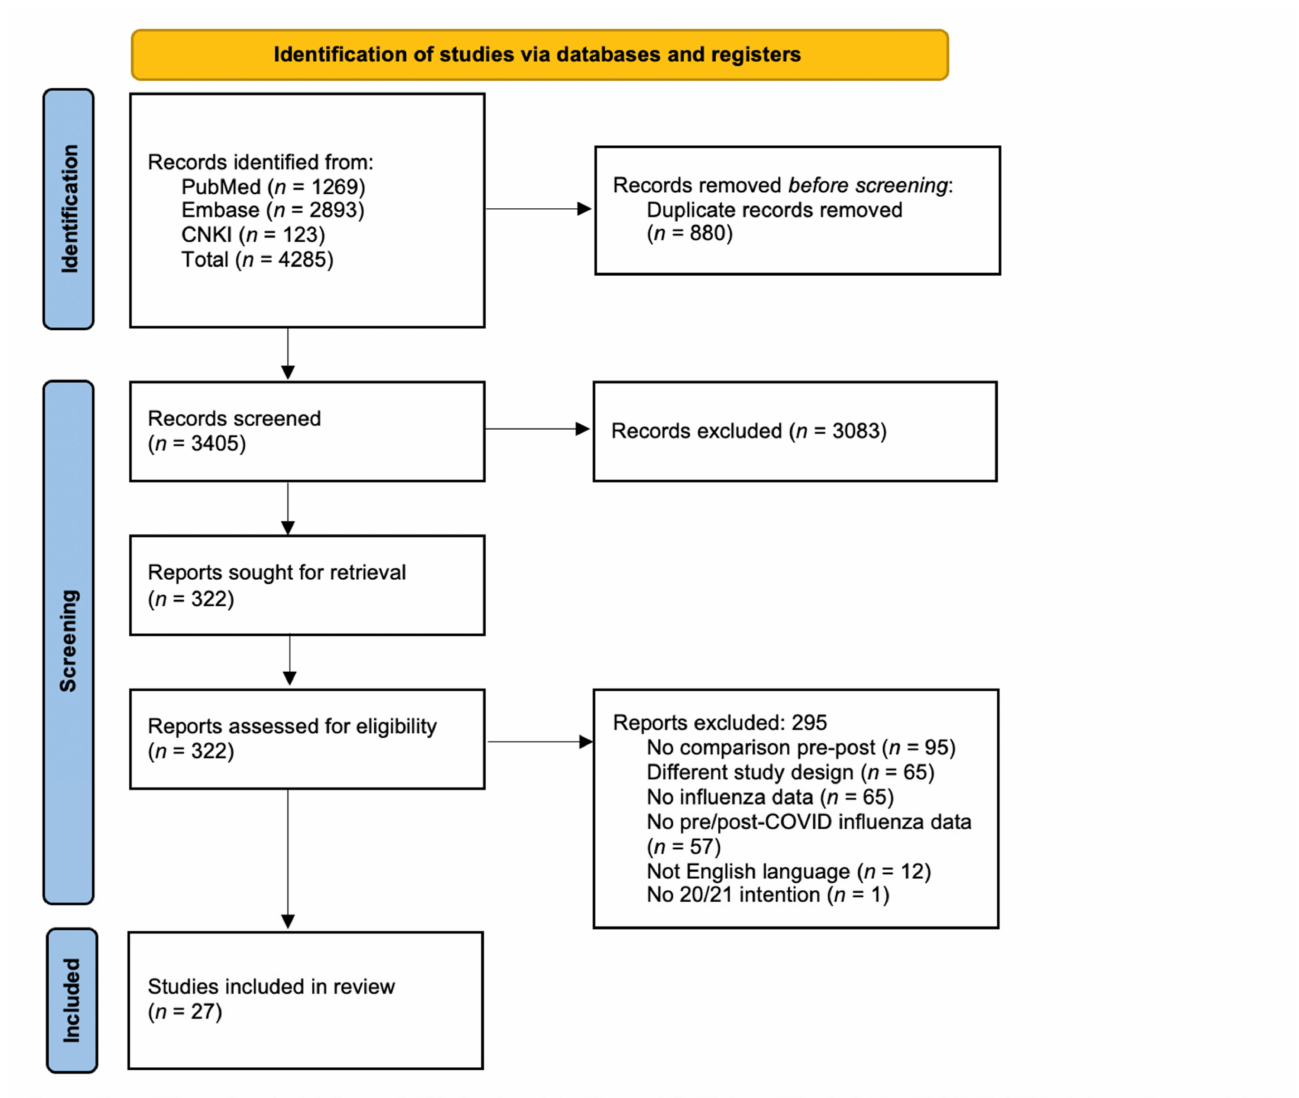
Figure 1. PRISMA flowchart of included